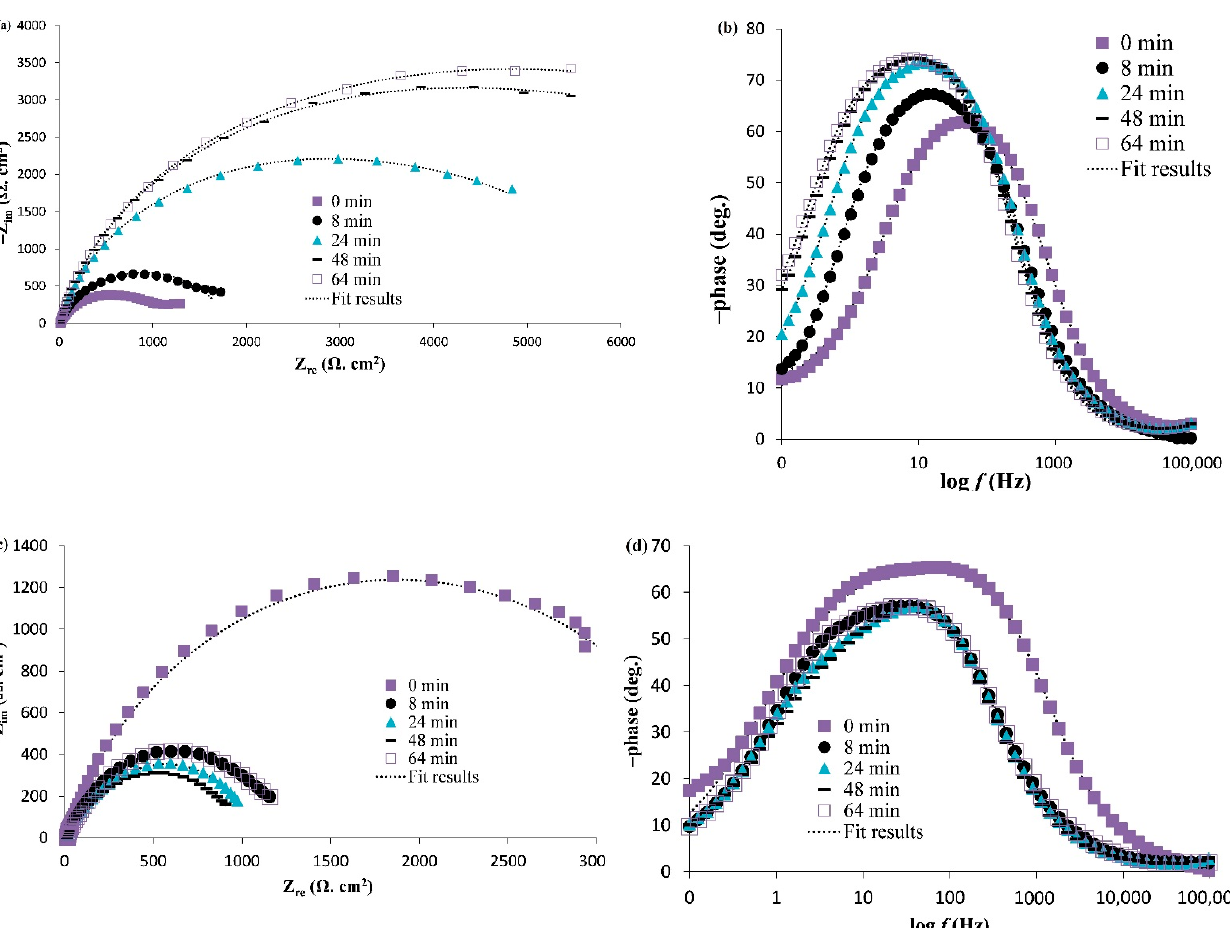
Figure 6. Nyquist and Bode plots of ( a , b ) NiW chloride and ( c , d ) NiW sulfate coatings before erosion–corrosion (0 min) and during 64 min of erosion–corrosion